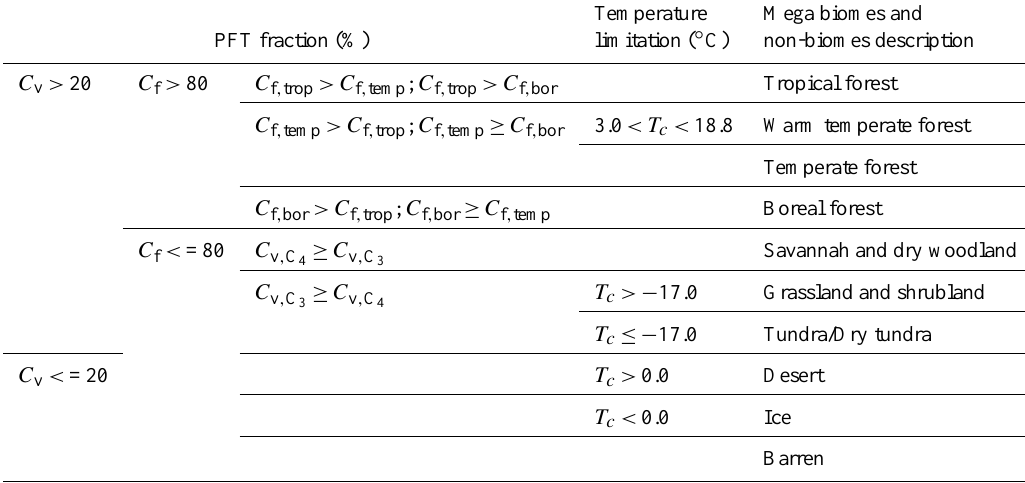
Table 3. The biome distribution estimation scheme adopted from a study by Schurgers et al. (2006) applied to the CCSM3 output. The temperature limitation is based on bioclimatic parameters for survival and establishment of PFTs in the CCSM3 (Bonan et al.,